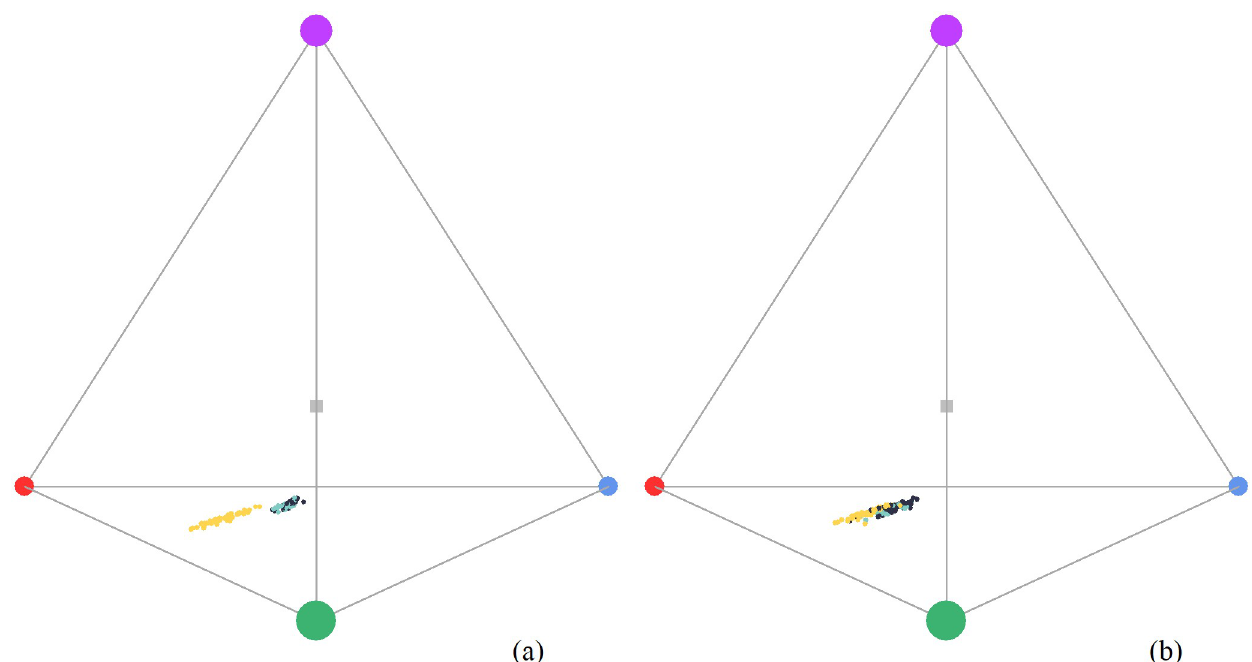
Fig 2. (A). Belly plumage color spectra in the tetrahedral color space. Each circle represents an individual. Vertices of the tetrahedron indicate type of cone: Ultraviolet (violet), short (blue), medium (green), long (red). Yellow circles are after second-year males, blue circles are females, teal circles are second-year males, and the grey square represents the achromatic origin or center of the tetrahedron. (B). Axillaries plumage color spectra in the tetrahedral color space. Each circle represents an individual. Vertices of the tetrahedron indicate type of cone.